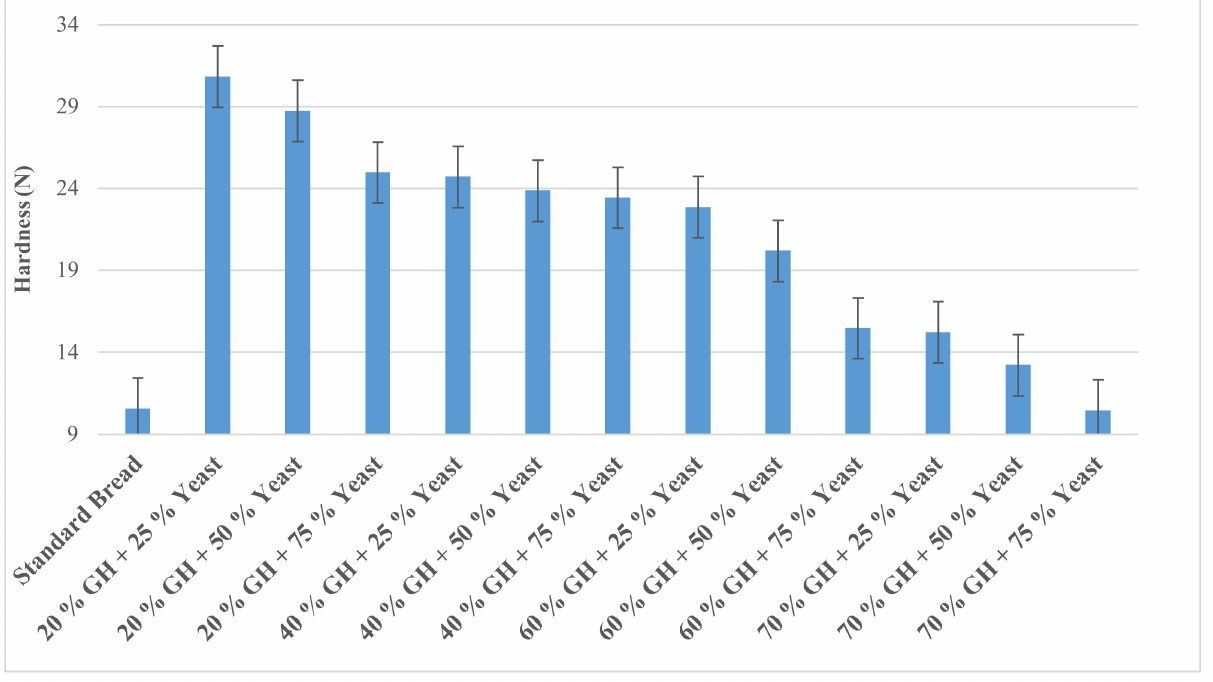
Figure 7. Hardness profile of standard and GH breads (20–70%) with promoters and 25–75% yeast as partial